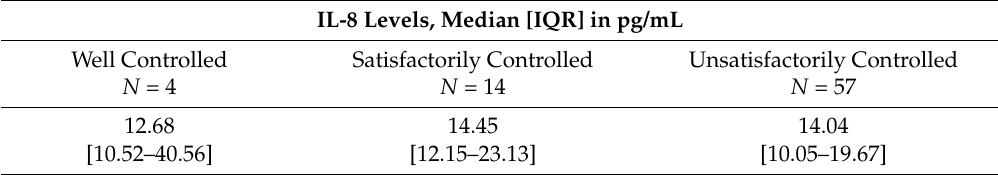
Table 2. Comparison of IL-8 plasma levels in diabetic patients according to their glycemic